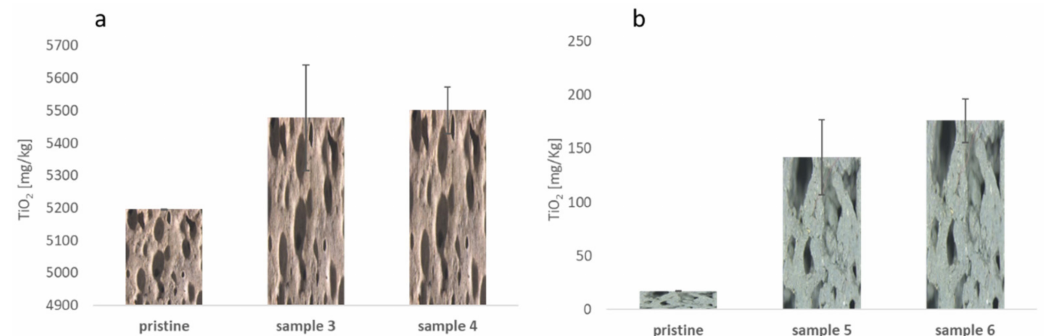
Figure 6. Amount of TiO 2 concentration on SUNSPACE samples synthetized by ( a ) bottom ash (samples 3 and 4) and ( b ) silica fume (samples 5 and 6). Pristine samples were not in contact with titania nanoparticles. The other samples were exposed to TiO 2